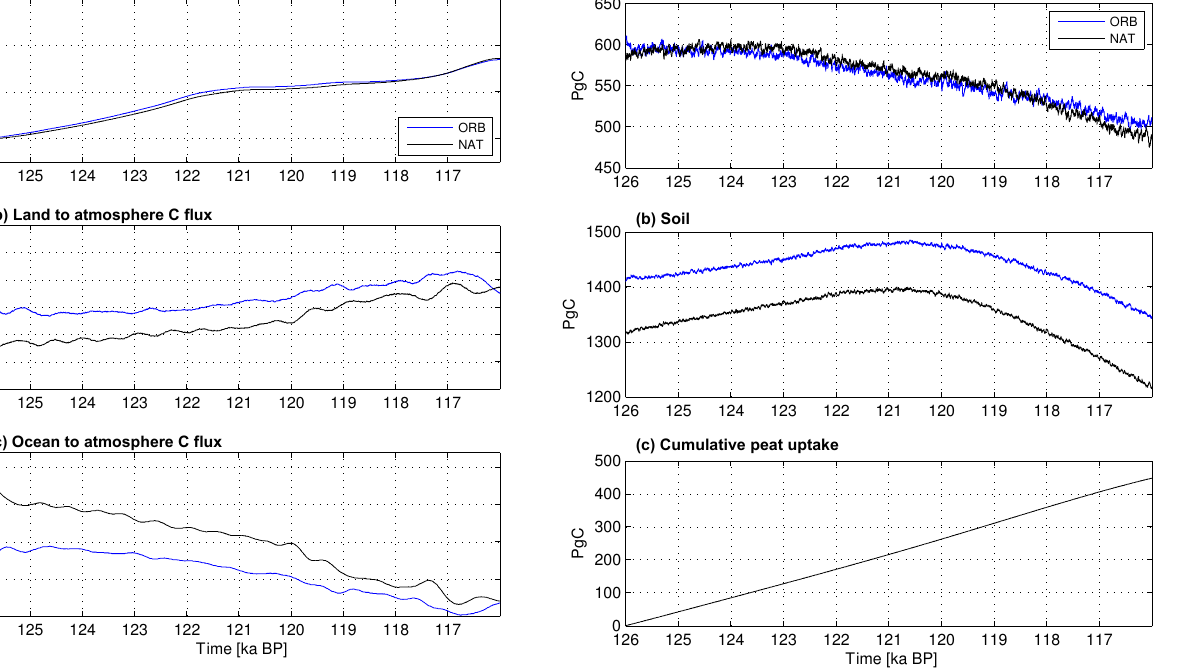
Figure 8. Land carbon pools in the Eemian experiments: total veg- etation carbon (a) , total non-peat soil carbon (b) and cumulative C uptake by peatlands (c)